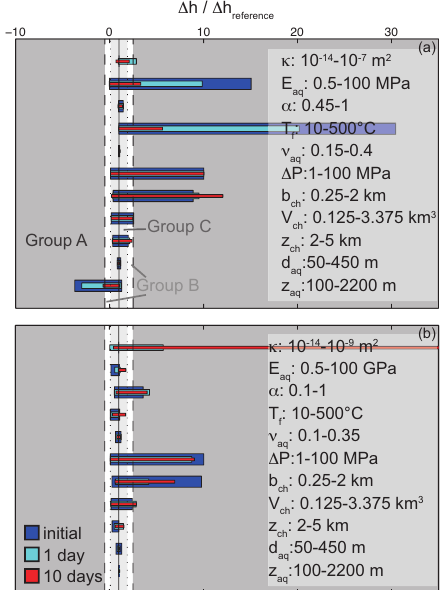
Figure 4. Exemplary plots used for the sensitivity analysis, show- ing the influence of changing a parameter (whilst keeping all others constant) on the central, initial hydraulic head change. (a) Pyroclas- tic aquifer, (b) lava flow aquifer. Dashed lines/grey areas indicate the priority bounds and groups that were used to rank parameters according to their importance (Table 4). For specification of sym- bols please refer to Table